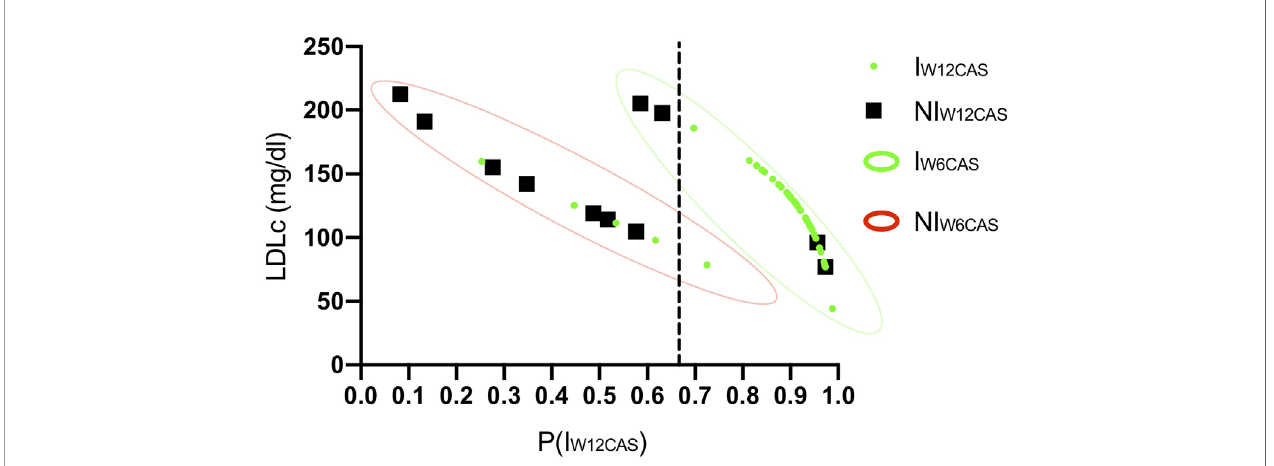
FIGURE 3 | Suggested decision-making algorithm. The graphs are constructed on the basis of binomial logistic regression prediction using the Youden ’ s best cut- off P(I W12CAS ) = 0.66. Each dot refers to a single patient; green dots refer to patients classi fi ed as Improved at W12CAS, while black dots refer to Not Improved Patients. The predicted probability of improvement at W12CAS [P(I W12CAS )] provided by regression analysis is positioned on the x axis; cut-off = 0.664 (dotted line). The continuous predictive variable included in the model (LDLc) is positioned on the Y axis. The categories of the dichotomous predictive variable (W6CAS outcome) are highlighted in green (I W6CAS ) or red (NI W6CAS ) contour